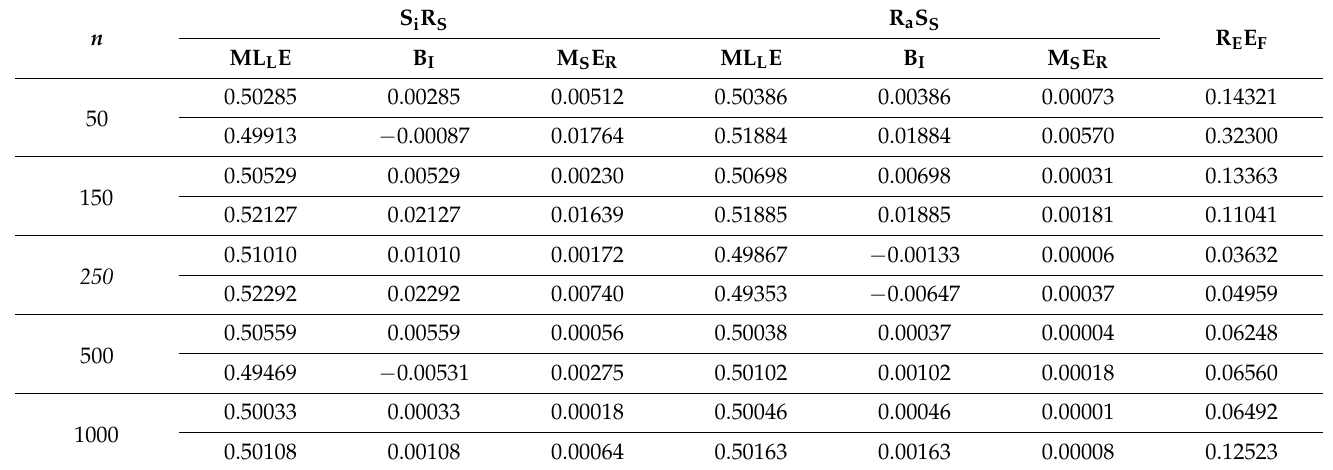
Table 4. The ML L E s , B I s, M S E R , and R E E F of the KMB X model under S i R S and R a S S at α = 0.5, β = 0.5.